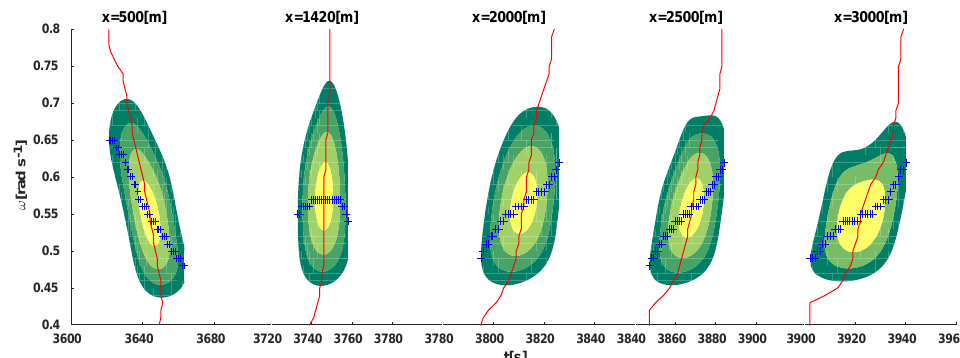
Figure 15. Case W100. A filled contour plot of the energy distribution of the critical group event at various positions. At each position, the red solid lines show the time of maximal energy at each wave frequency. The ++ lines show the wave frequency as function of time. Both are estimated by the most energetic waves in time and frequency, respectively. Both lines show a decreasing frequency before the freak wave and an increasing frequency after the freak wave, while the freak wave occurs at x = 1420m.